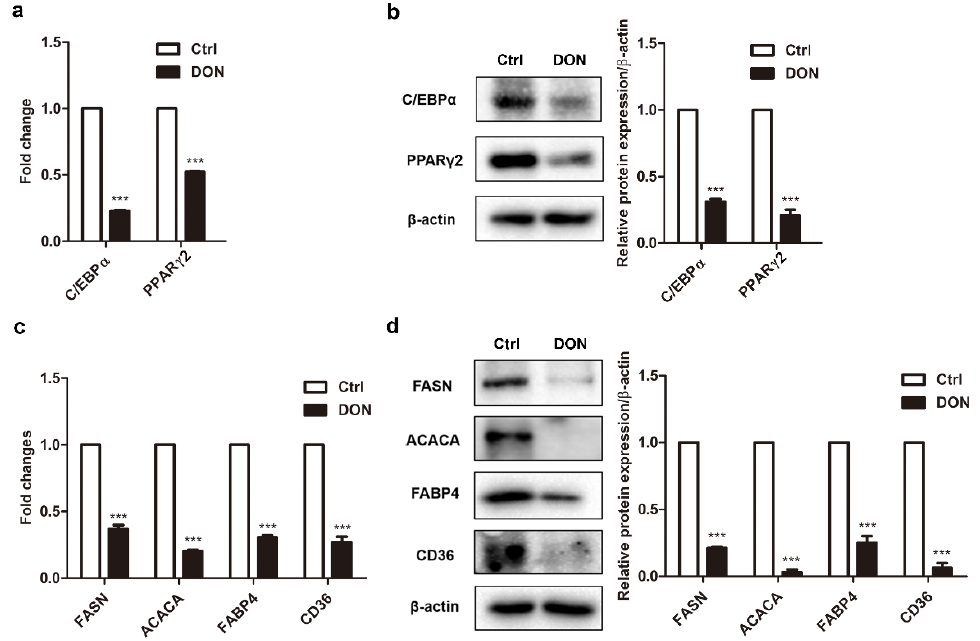
Figure 6. The effect of DON on the expression of adipogenic marker genes in mice ( n = 5). ( a , c ) C/ebpα , Pparγ2 , Fasn , Acaca , Fabp4 , and Cd36 mRNA levels in mice. ( b , d ) C/EBPα, PPARγ2, FASN, ACACA, FABP4, and CD36 protein levels in mice (left). Quantification of protein levels (right). The results are representative of three independent experiments, and statistical significance is indicated by *** p < 0.001. 2.7. DON Suppressed the Expression of PPARγ2 by Inhibiting the Enrichment of H3K4me2 and H3K4me3